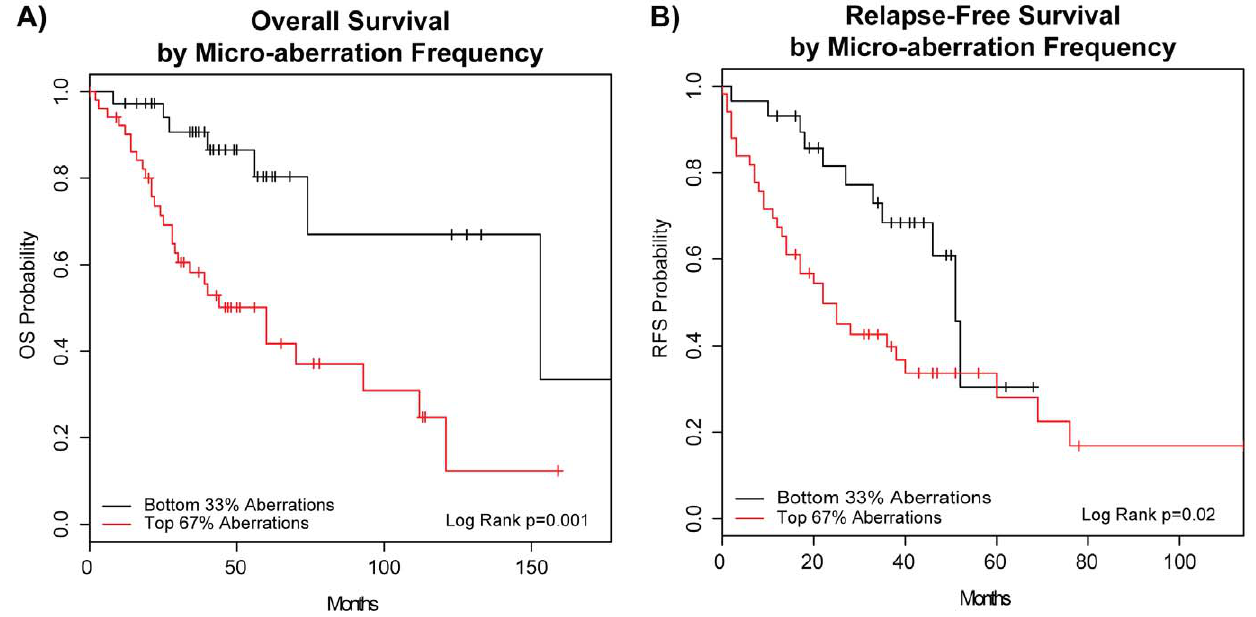
Figure 6. Higher levels of micro-aberrations are associated with worse survival outcomes. A) Kaplan-Meier plots for overall survival and B) relapse-free survival are shown for the patients in the tiling array datasets. The patients were split into two groups, the top 67% in terms of total